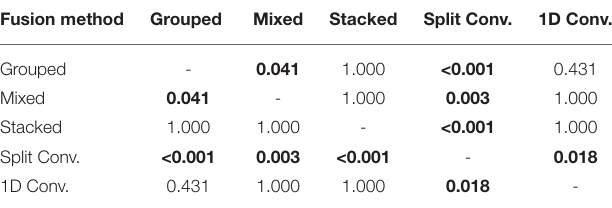
TABLE 3 | The p values obtained from the pairwise comparisons in the one-way ANOVA comparing the accuracy of the different CNN based EEG–EMG fusion